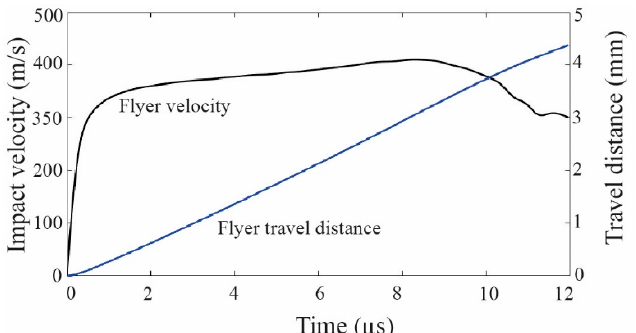
Figure 4. Flyer velocity and travel distance as a function of time ( E = 3.1 J, D = 5.5 mm, t = 114 μ m).